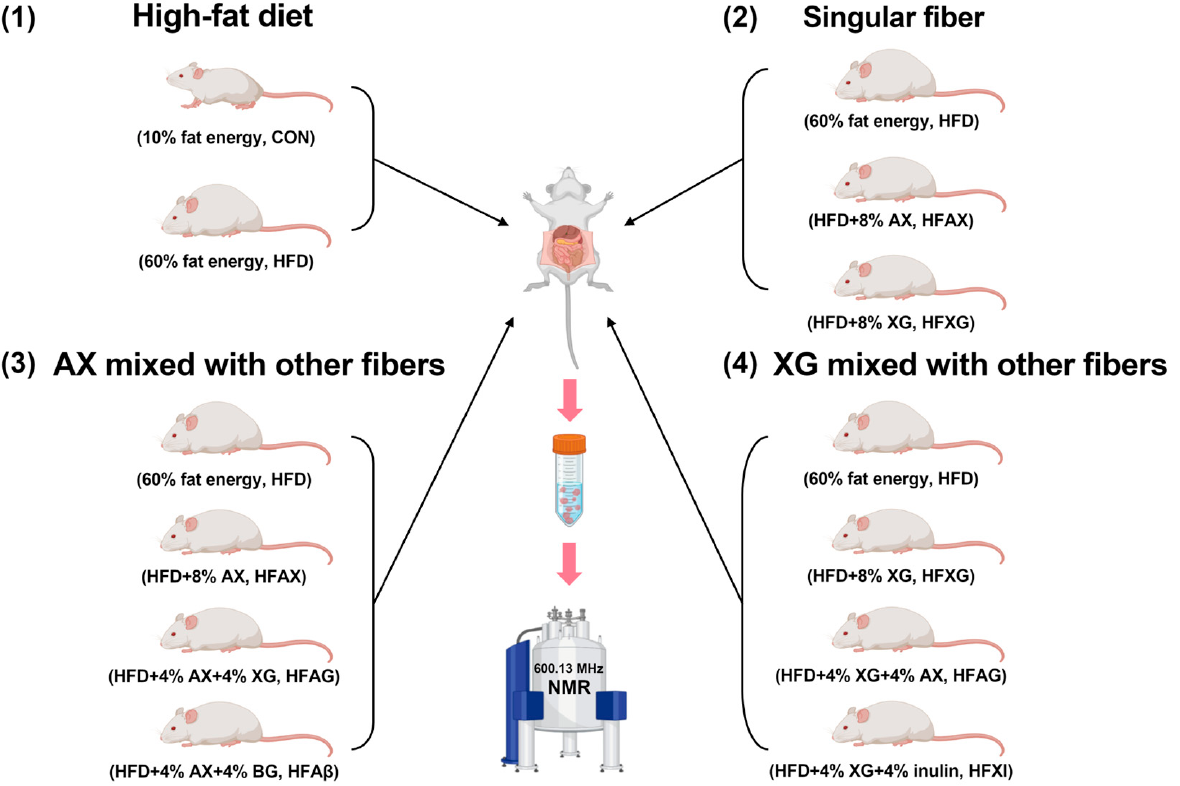
Figure 1. A scheme of experimental design.